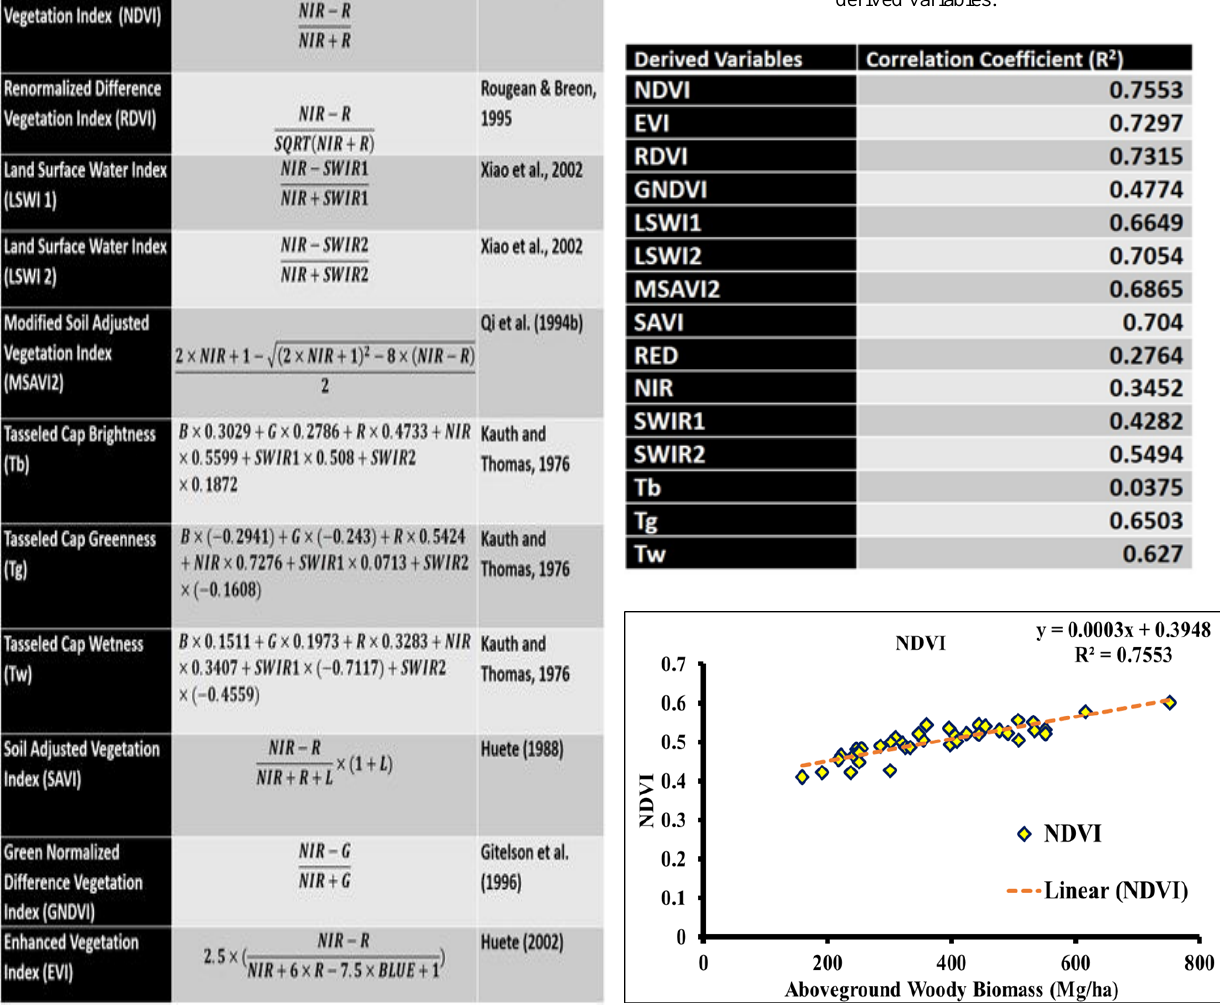
Table 5. Correlation coefficient between AGWB and Satellite derived variables.